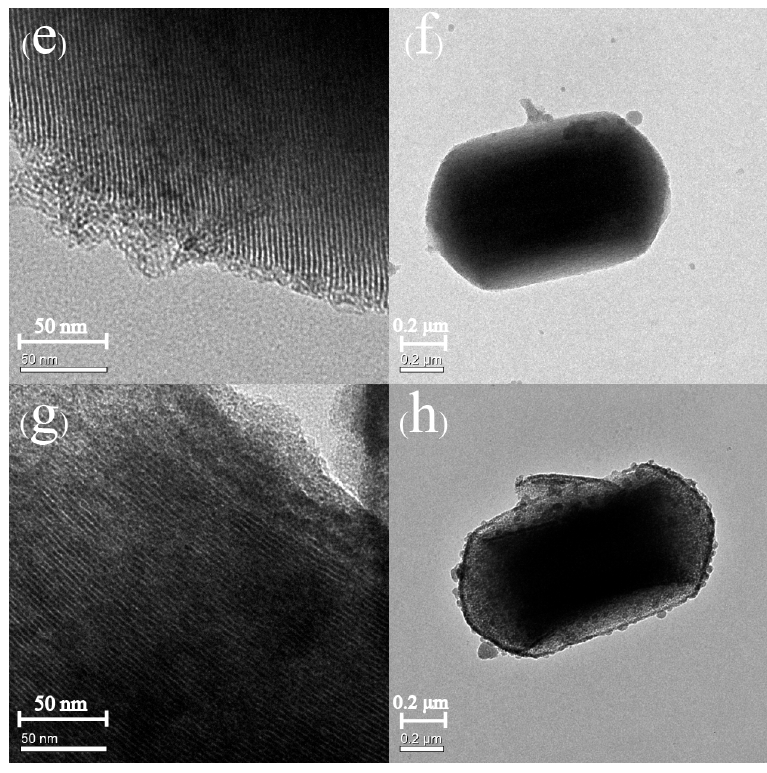
Figure 5. Transmission electron microscopy (TEM) images of MCM-41 ( a , b ), Sal-MCM ( c , d ), ZnO-MCM-0 ( e , f ), and ZnO-MCM-9 ( g , h ).